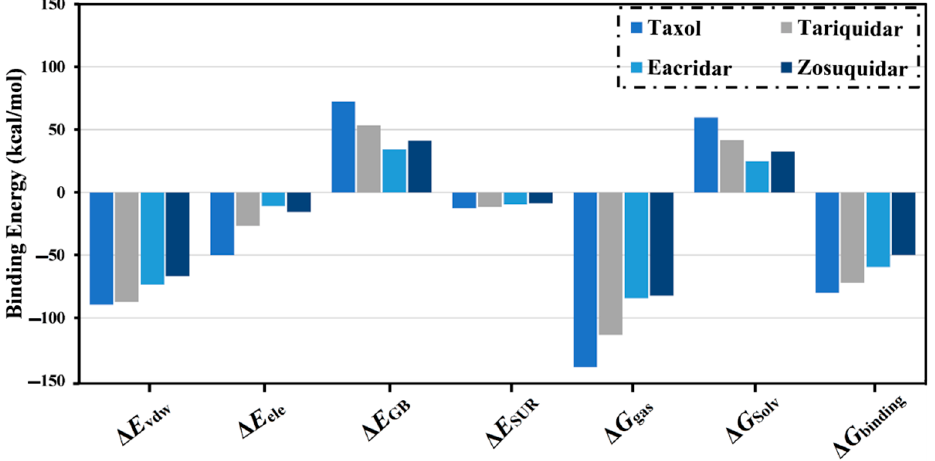
Figure 2. Components of the MM-GBSA approach for taxol, tariquidar, elacridar, and zosuquidar complexed with ABCB1 transporter over the 100 ns MD simulations.